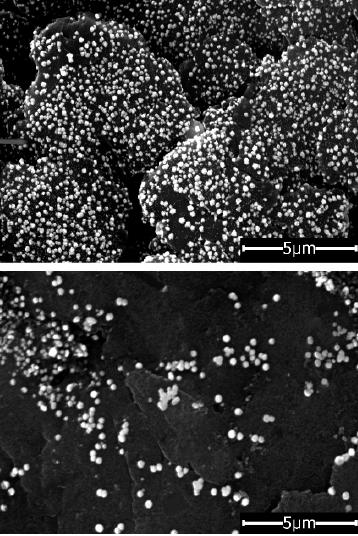
Figure 2. FESEM images of GCE/N-rGO-Au (20 cycles) and GCE/rGO-Au (30